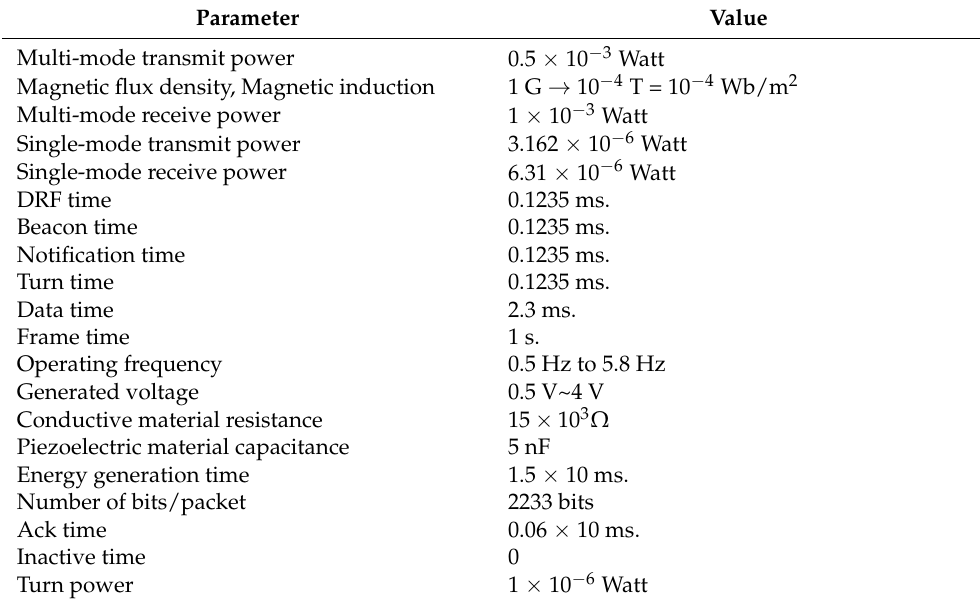
Table 2. Simulation